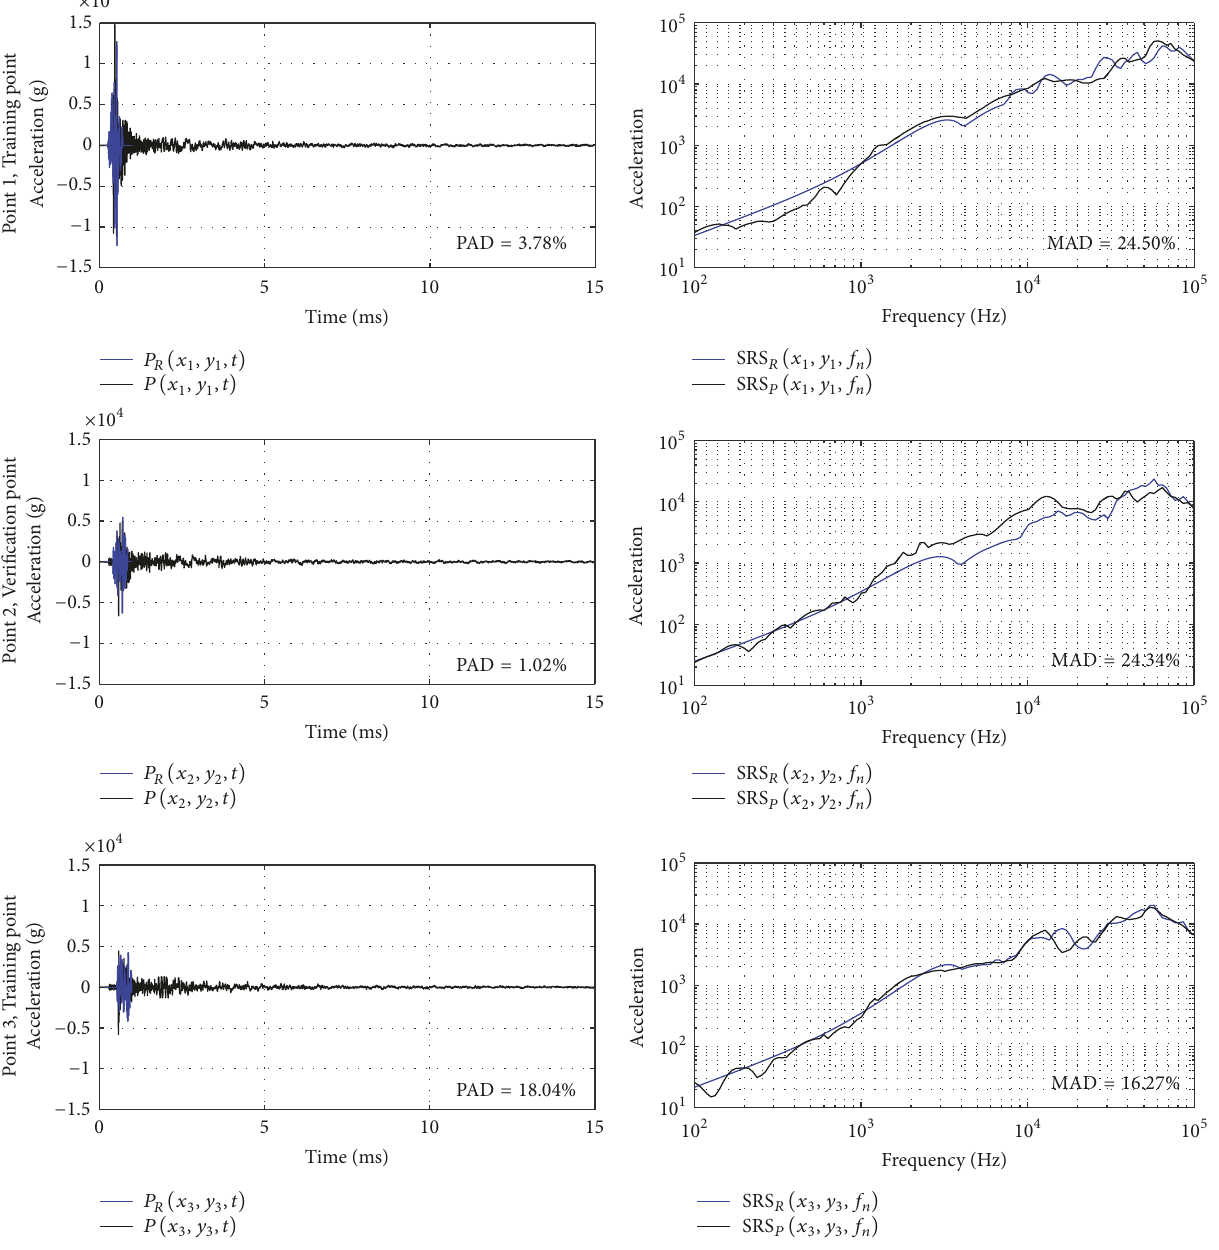
Figure 19: Time domain signal reconstruction result in using point 2 as a verification point.